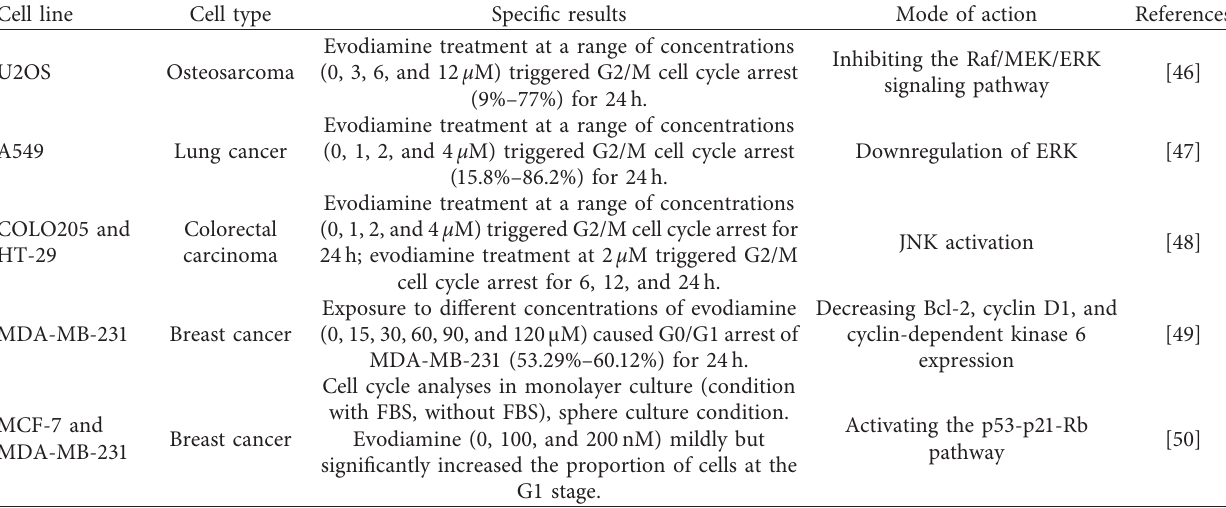
Table 2: Induction of cell cycle arrest by evodiamine in cancer cell lines in